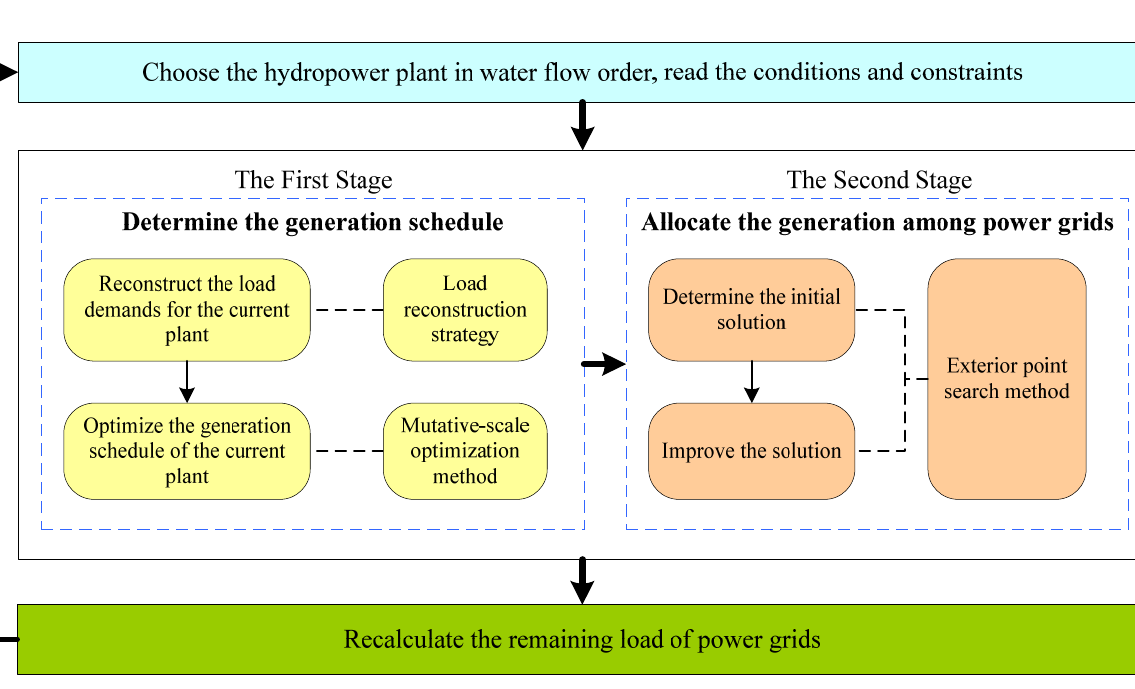
Figure 2. Solution